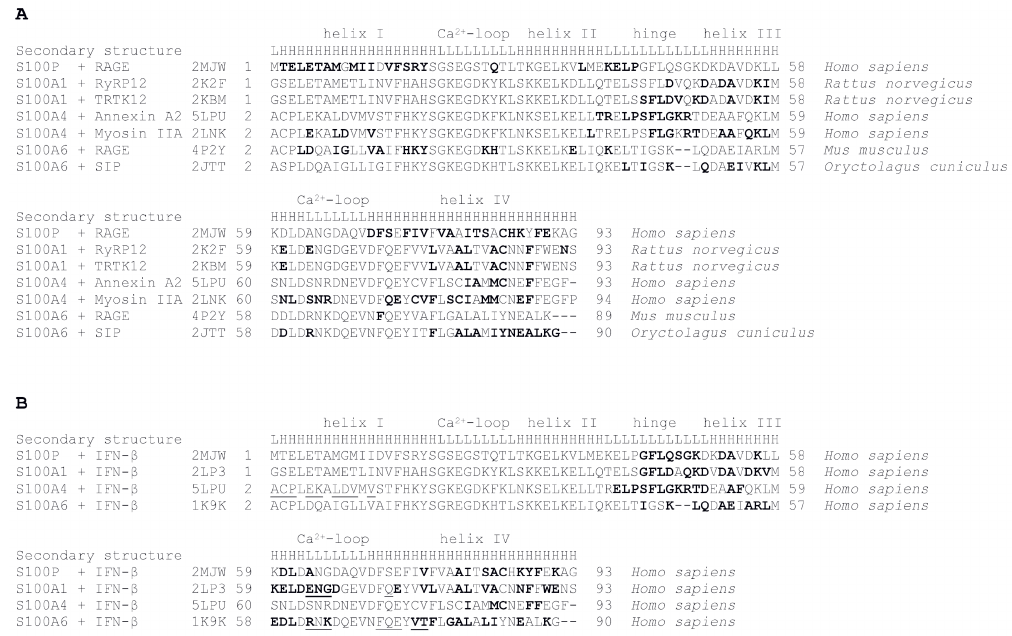
Figure 8. Amino acid sequence alignment for the S100 proteins specific to IFN- β , derived from overlay of their tertiary structures on that for human S100P using DALI server [59]. The residues of the primary monomers of the S100 proteins involved in the interaction with either target proteins (panel A ) or human IFN- β ( B ), determined with LPC software [60], are shown in bold. Model structures of the S100—IFN- β complexes are shown in Figure 8. The residues of the secondary monomers of the S100 proteins predicted to be involved in the interaction with IFN- β are underlined ( B ). PDB codes used for the analysis and secondary structure elements (“L” and “H” denote loops and α -helices, respectively) are